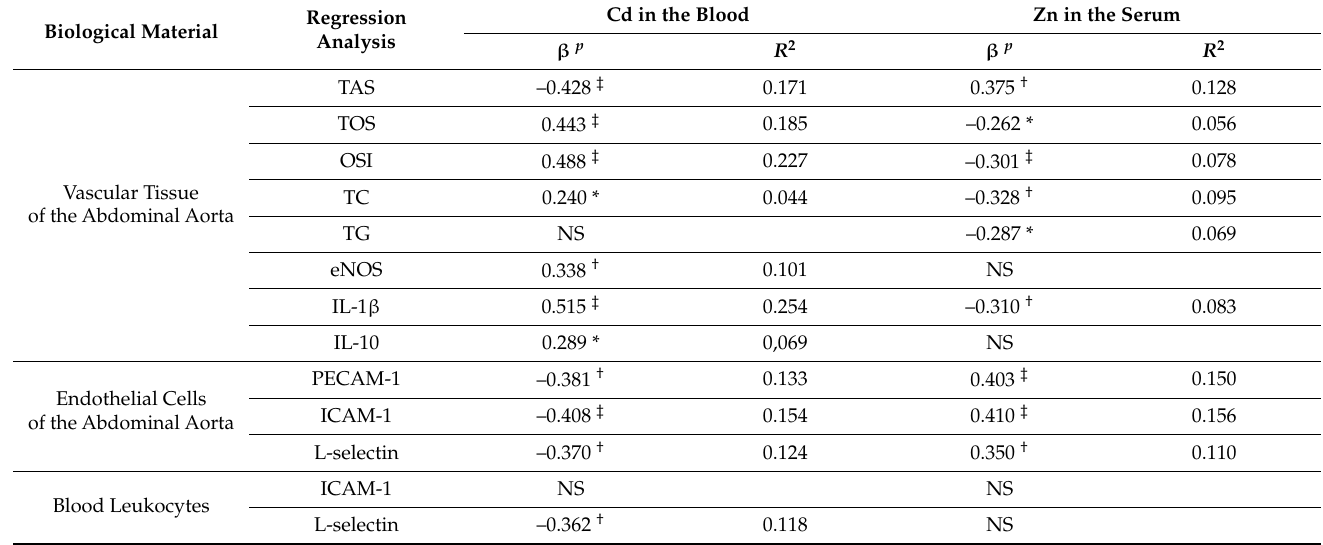
Table 10. Mutual relationships between the investigated parameters and the concentrations of Cd in the blood and Zn in the serum 3